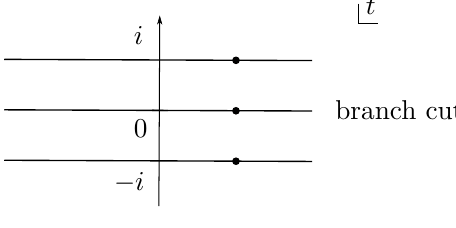
Figure 9 . Sketch of G mod ( x, y, t ) (4.16), for fixed x, y belonging to a single interval on the plane or cylinder (P). The function is analytic in the interior of each strip and antiperiodic amongst strips due to the KMS condition. Just as in the plane, it possesses simple poles (black dots) along = ( t ) ∈ Z . However, the novelty here is that in addition it has branch cuts, indicating that the modular flow is completely non-local as explained around